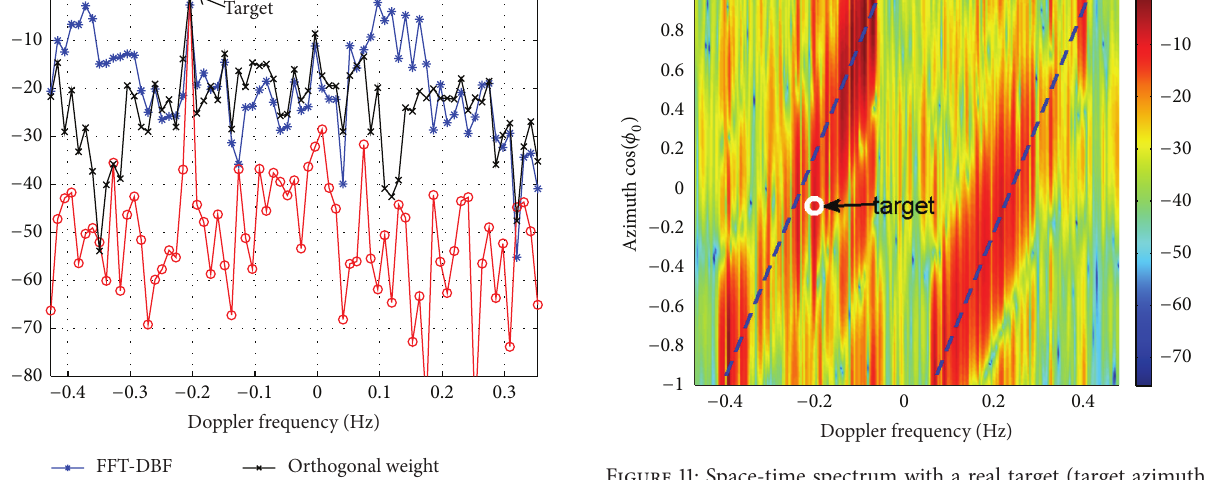
Figure 11: Space-time spectrum with a real target (target azimuth 95 ∘ ).